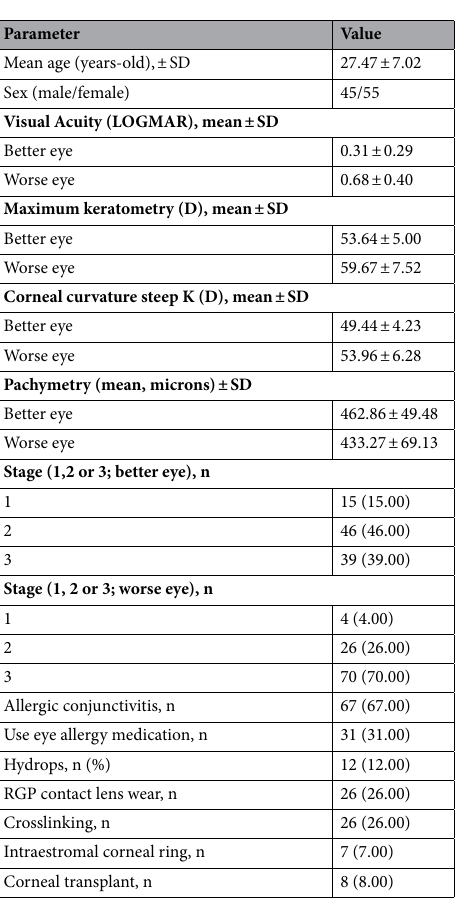
Table 3. Demographic characteristics and clinical variables of keratoconus patients. SD Standard deviation; D Diopter; RGP rigid gas